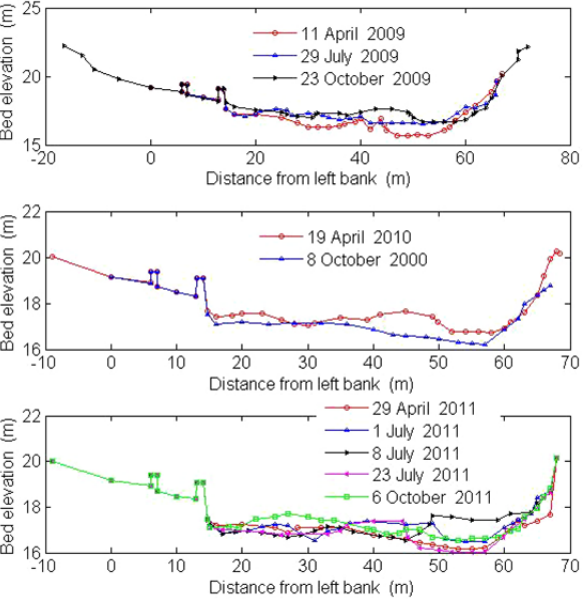
Figure 11. Elevation change of cross section in Shangcun hydro- logical station (2009–2011) (left for left bank, right for right